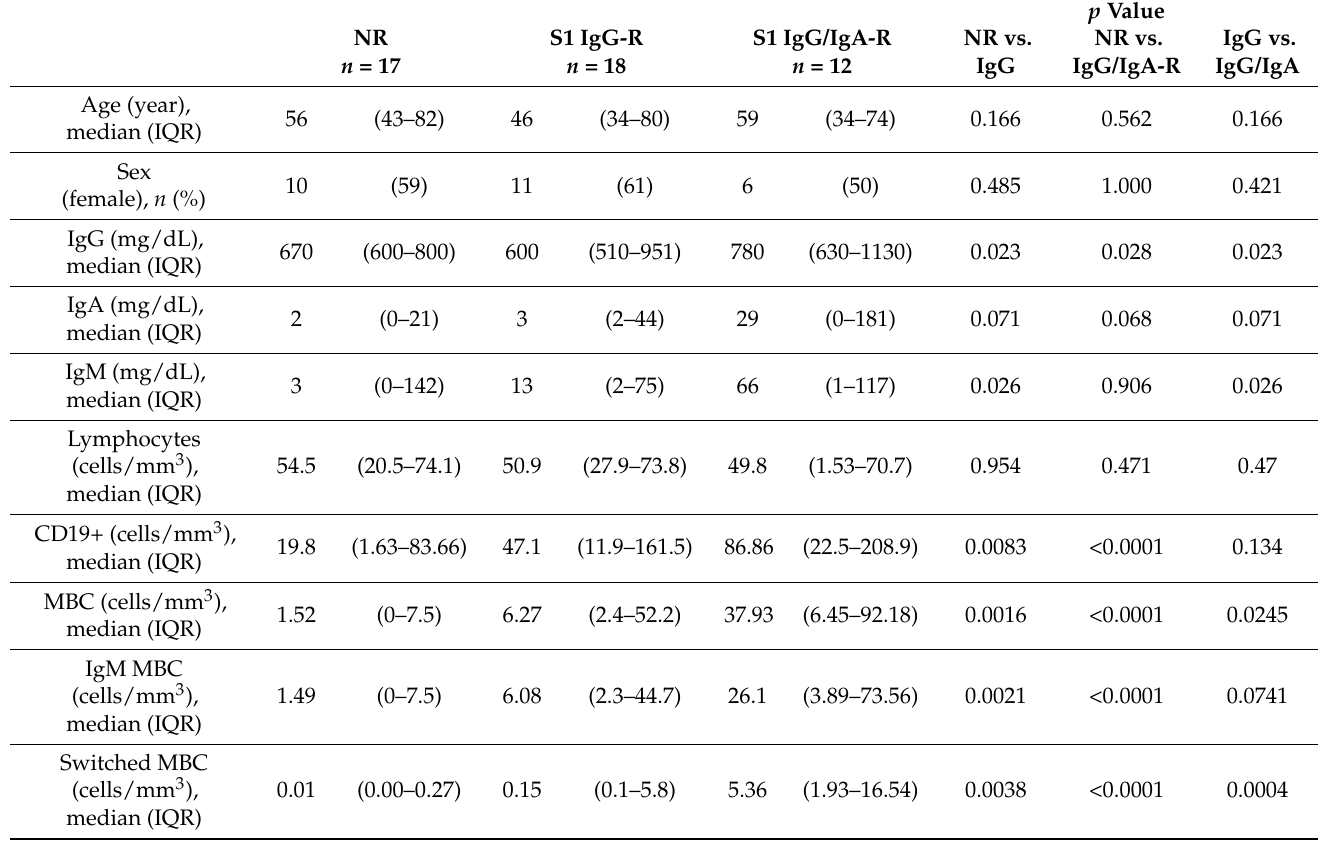
Table 1. Characteristics of CVID patients classified on the basis of anti S1 IgG- and IgA-antibody production following the third BNT162b2 mRNA COVID-19 vaccination dose.